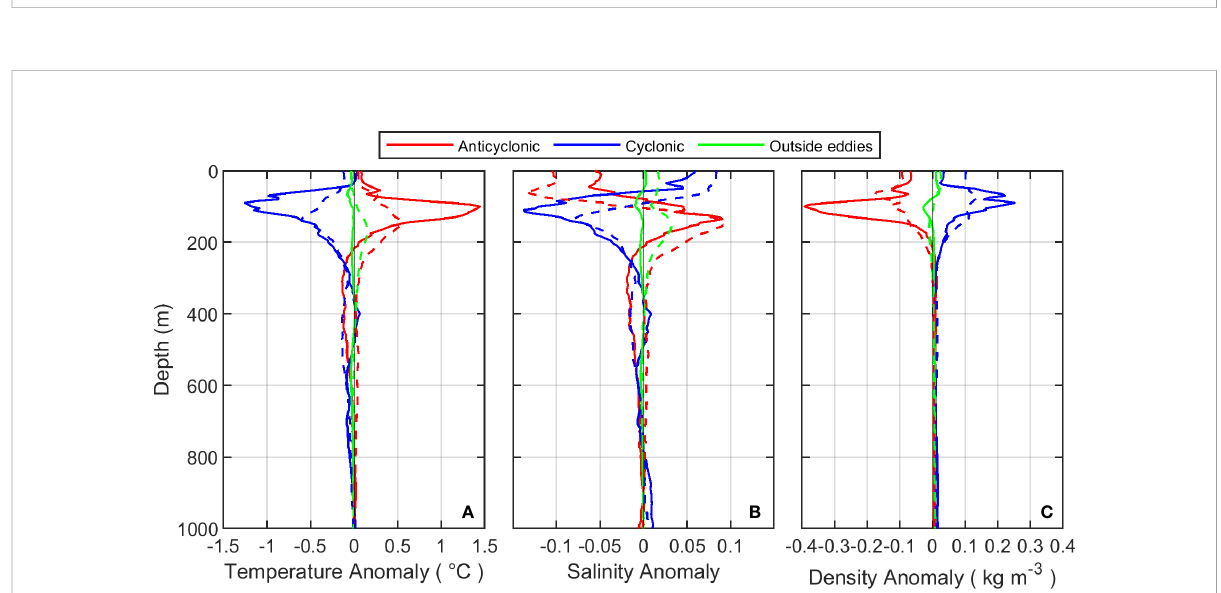
FIGURE 13 Mean vertical pro fi les of (A) temperature anomaly, (B) salinity anomaly, and (C) density anomaly in regions A and (B) Solid lines (dashed lines) correspond to the mean pro fi les obtained in region A (B) for the composite CE (blue lines), AE (red lines) and outside eddies (green